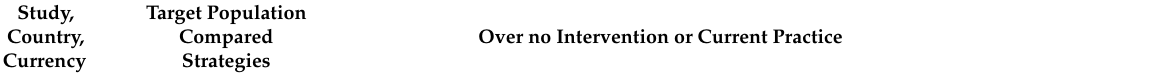
Table 5. Discounted Costs, Life Years, QALYs, and Incremental Cost-E ff ectiveness Ratios of Genetic Testing for Germline Mutations Followed by Risk-Reducing Interventions for Diagnosed Mutation